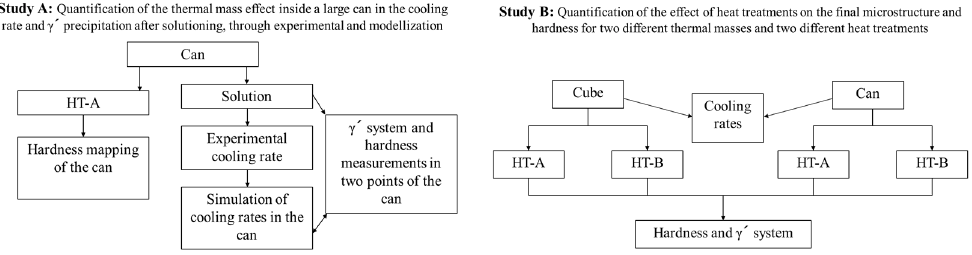
Figure 1. Graphical abstract of the steps performed in the paper. This work presents a new approach for the quantification of the influence of cooling rate effect on Astroloy microstructure and properties considering the thermal gradient formed inside very large specimens, whereas other studies reported the cooling rate effect due to different